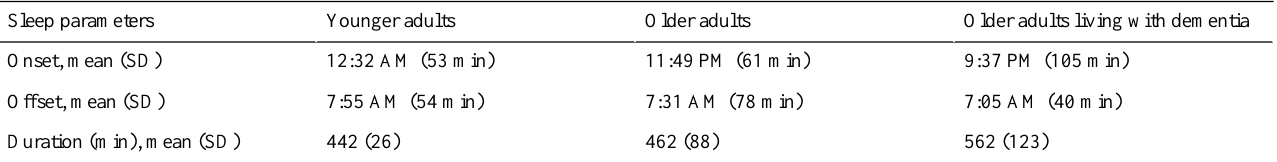
Table 1. Sleep parameters calculated from sleep journals (younger and older adults) and recreated sleep journals (older adults living with dementia).